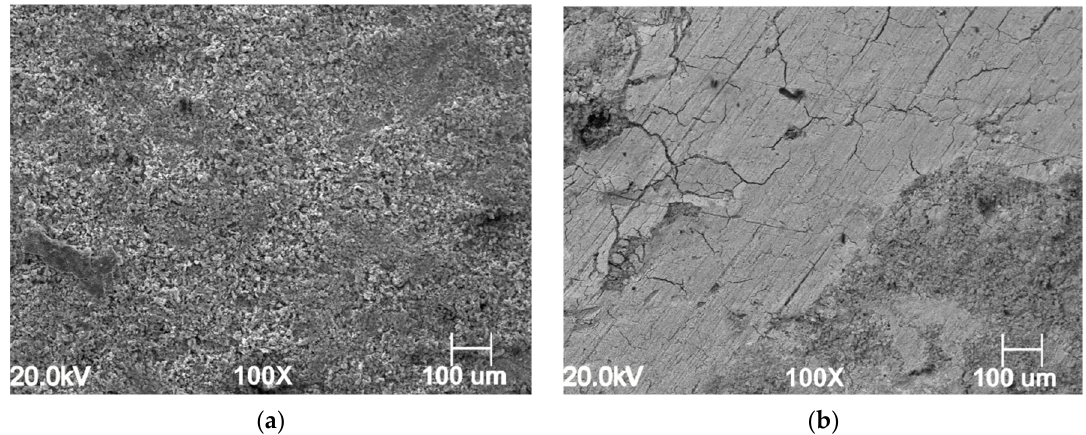
Figure 11. SEM images of the N80 carbon steel morphology after 24 h of immersion in the tested solution at P CO = 40 bar and at 60 °C, without ( a ) and with ( b ) the presence of GA. 2 EDS analysis reports high content of carbon, oxygen, and iron elements in both layers